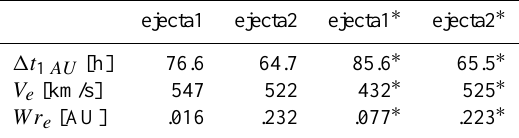
Fig. 5. Heliocentric evolution of the total ki- netic energy of ejecta 1 (top) and ejecta 2 (bottom) (cid:16) (cid:17) K e = (m p / 2 ) · P n V 2 (r i ) · N(r i ) · dϑ(r i ) . The dotted curve in i = 1 both plots shows the evolution when there was no interaction with other disturbance. Table 3. One-dimensional results at 1AU: ejecta transit time from ro ( 1t 1 AU ), ejecta front velocity ( V e ) and radial width ( Wr e ). ( ∗ ) ejecta propagates without interacting with other